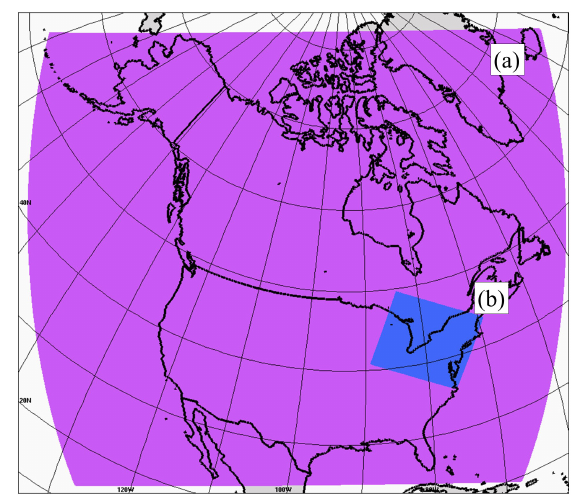
Figure 5. GEM-MACH test domains: (a) 10km grid cell size North American domain; (b) 2.5km grid cell size Pan Am